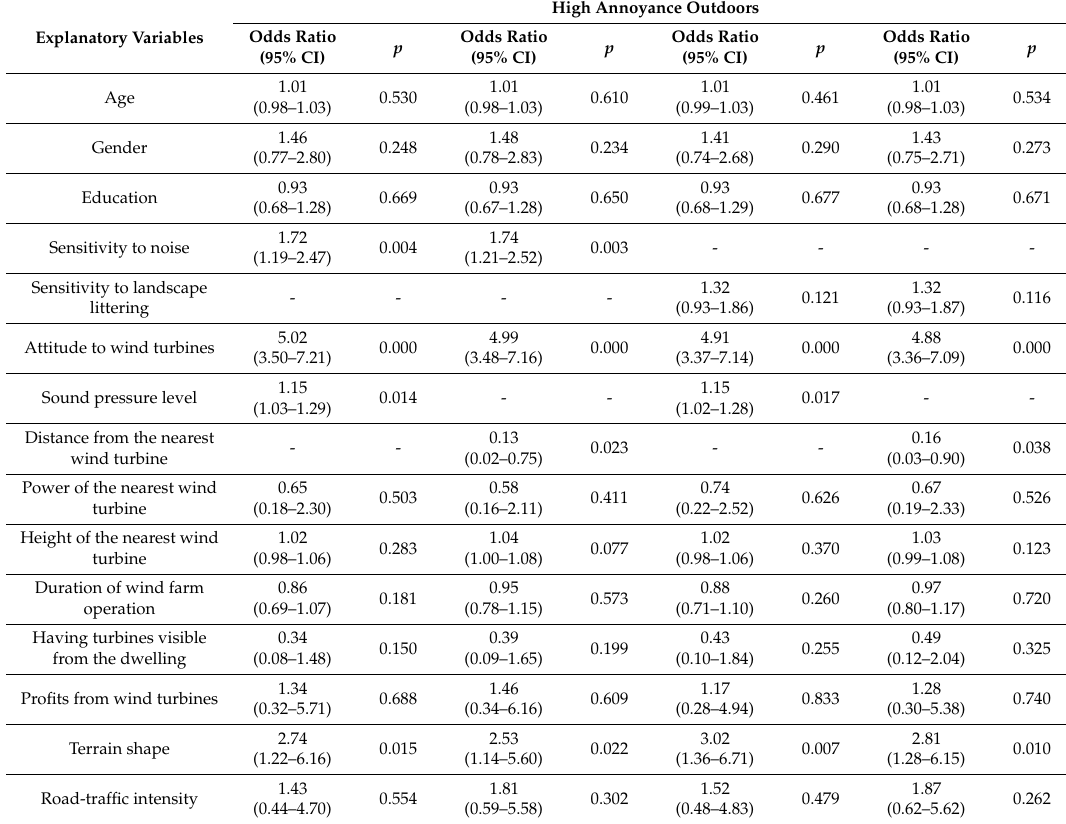
Table 8. Association between perception outdoors of high annoyance related to the wind turbine noise (dependent, binary variable) and the calculated A-weighted sound pressure level (or distance) as well as subjective (individual) and objective factors (independent variables) tested by logistic